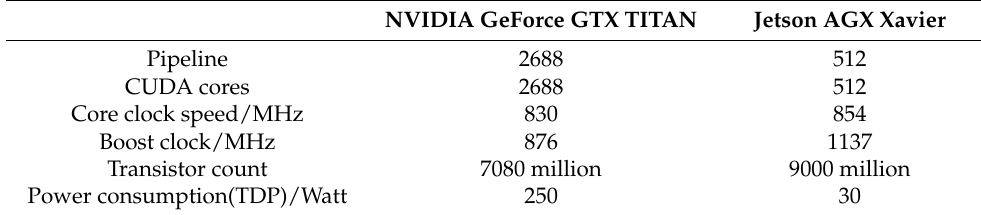
Table 1. Comparison of NVIDIA GeForce GTX TITAN and Jetson AGX